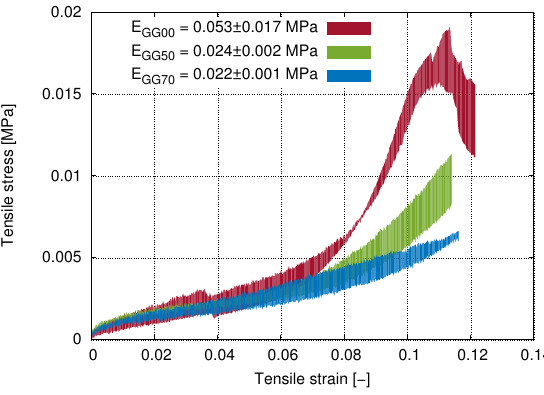
Table 5. Elastic properties of GG samples with 70 wt% BAG for compression test